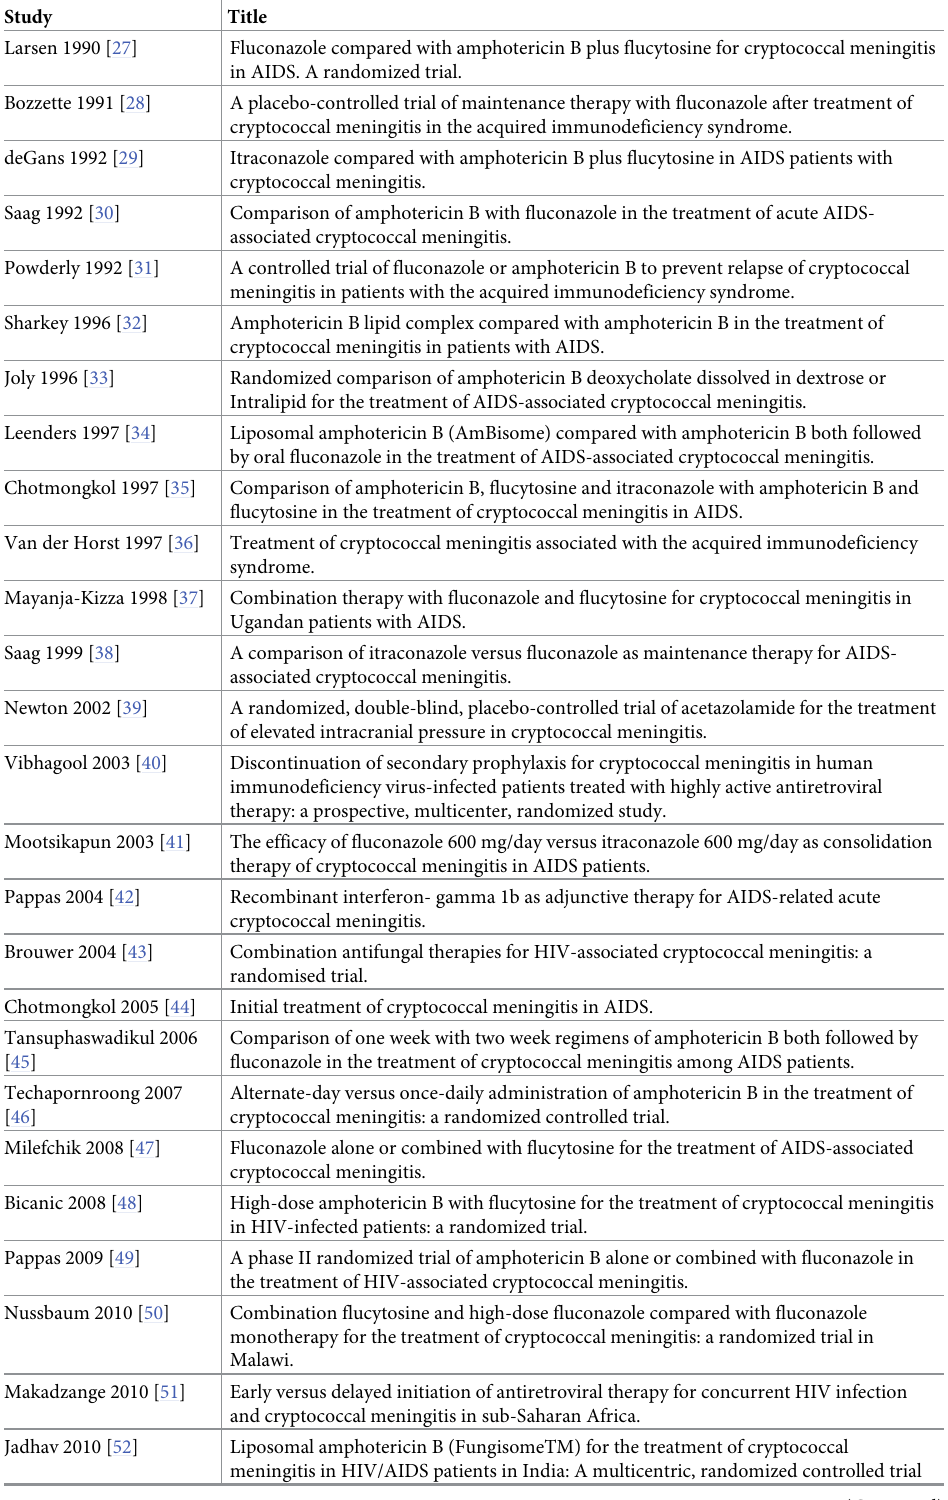
Table 2. A summary of the 39 included